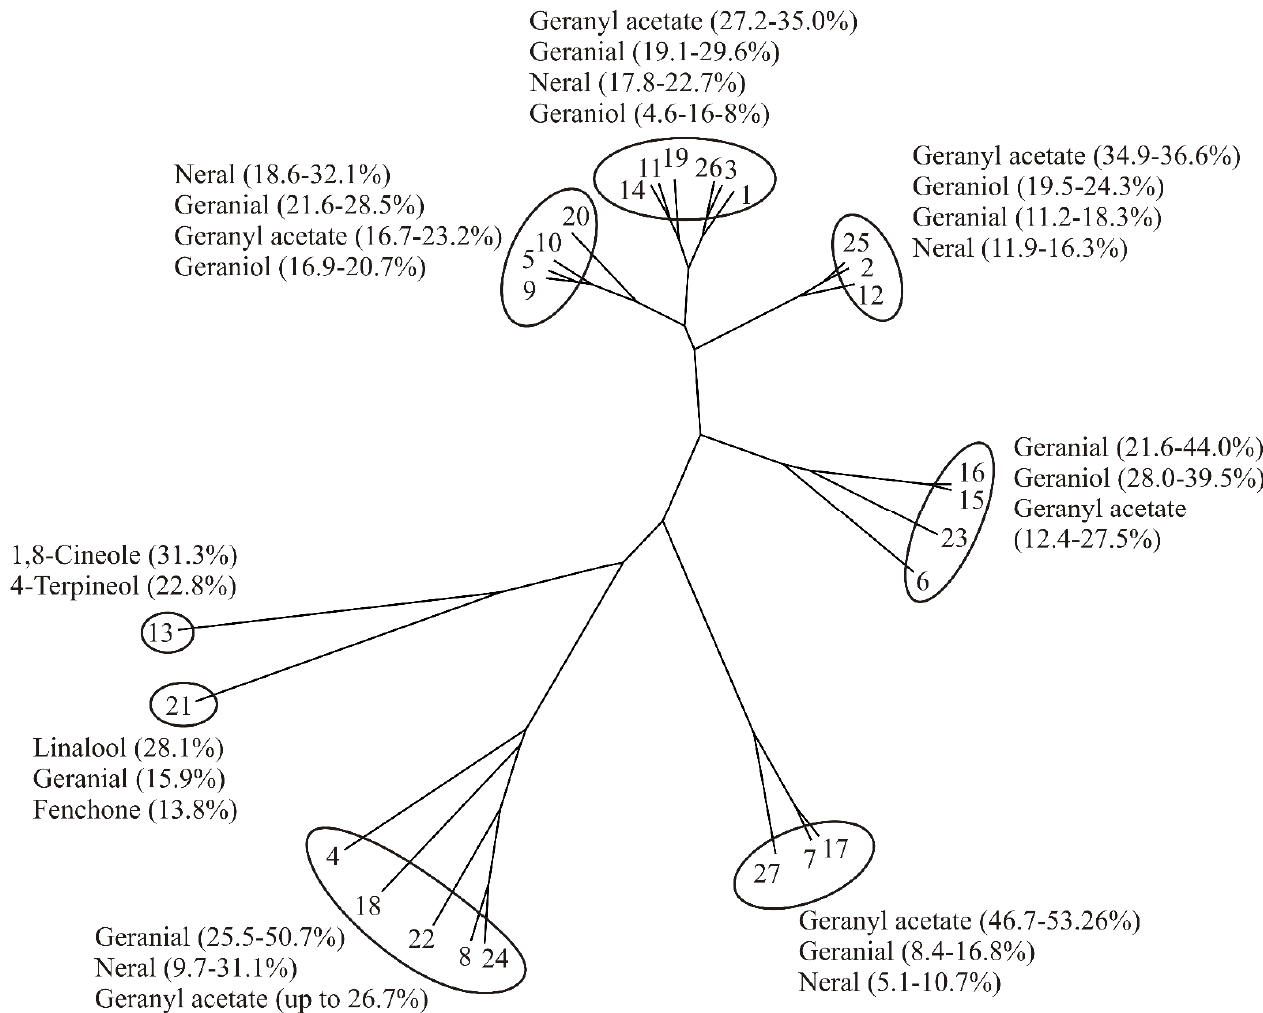
Figure 4. The unrooted phylogenetic tree of D. moldavica essential oil (DMEO) according to Table 8.